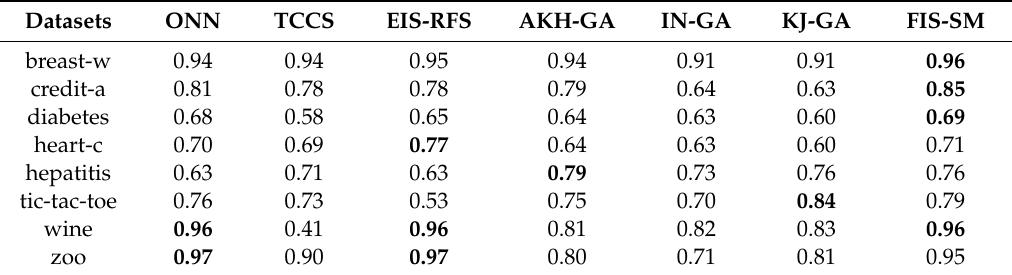
Table 11 o ff ers the Avg_Acc results of the Nearest Neighbor classifier without preprocessing (ONN), as well as the results of TCCS, EIS-RFS and the proposed FIS-SM. Best results are highlighted in bold. Table 11. Averaged accuracy by classes obtained by the